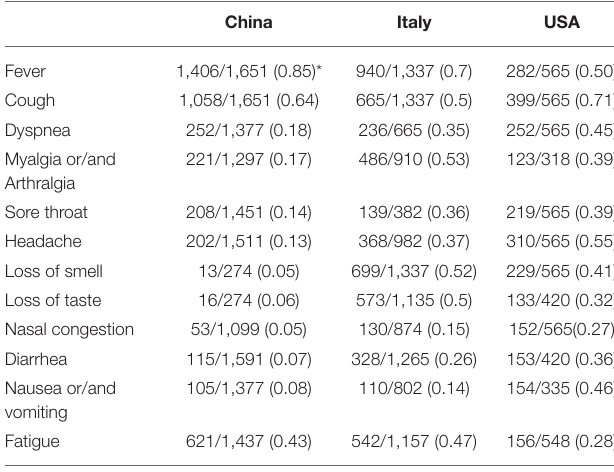
TABLE 1 | Comparison of common COVID-19 phenotypes in China, Italy and USA from December 2019 to May